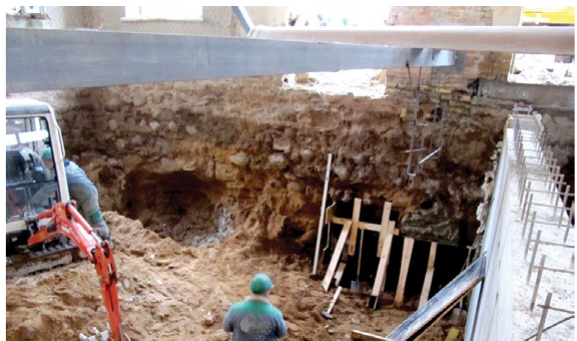
Fig. 9. Stress distribution: 1 – s stress after excavations; 3 – s